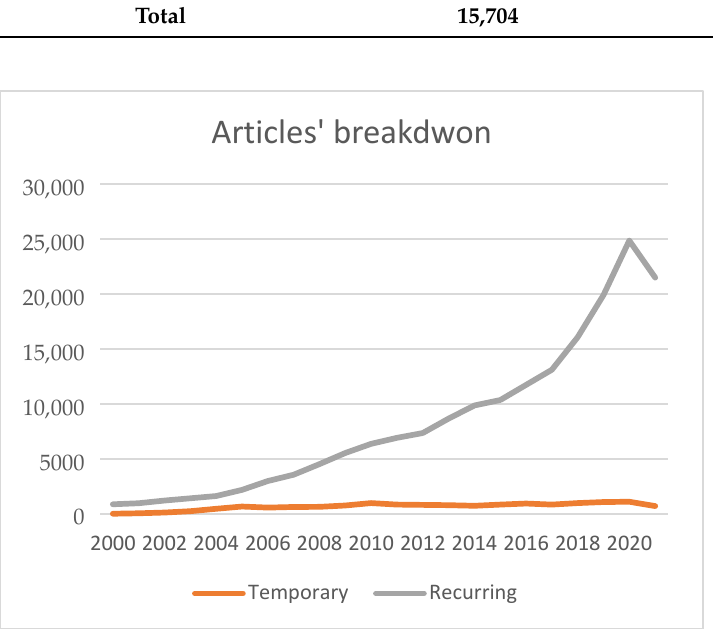
Figure 1. The breakdown of the articles based on their subject. Source: Extracted from various search engines including Science direct, Scopus and the Summon engine.